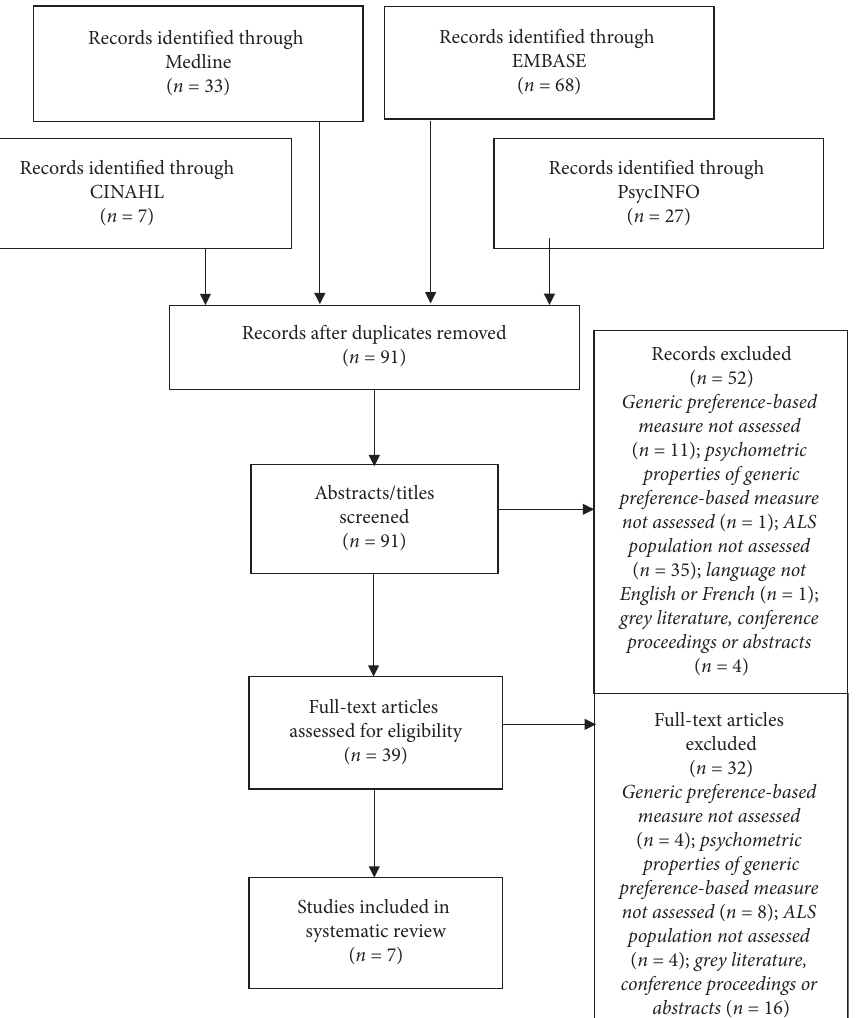
Figure 1: Flow diagram of article selection process (adapted from the PRISMA statement). 18 ALS Amyotrophic Lateral